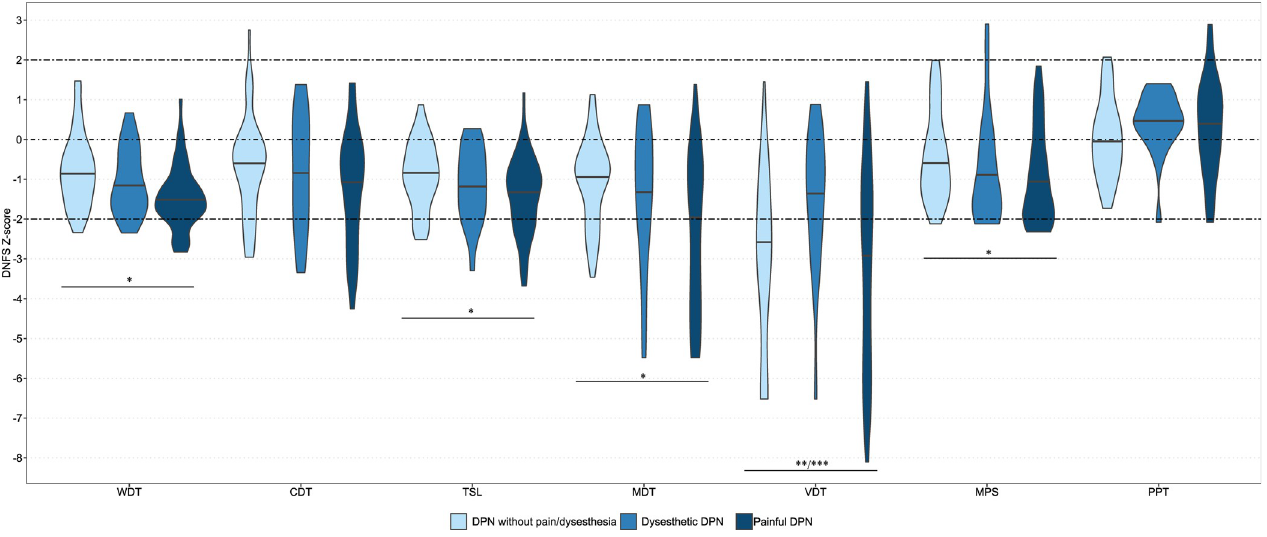
Fig 2. Median of QST Z–scores in DPN without dysesthesia/pain, dysesthetic DPN, and painful DPN. WTD, warm detection threshold; CDT, cold detection threshold; TSL, thermal sensory limen; MDT, mechanical detection threshold; VDT, vibration detection threshold; MPS, mechanical pain sensitivity; PPT, pressure pain threshold. P < 0.05 is notified by: � pain vs no dysesthesia/pain, �� dysesthesia vs no dysesthesia/pain, ��� pain vs